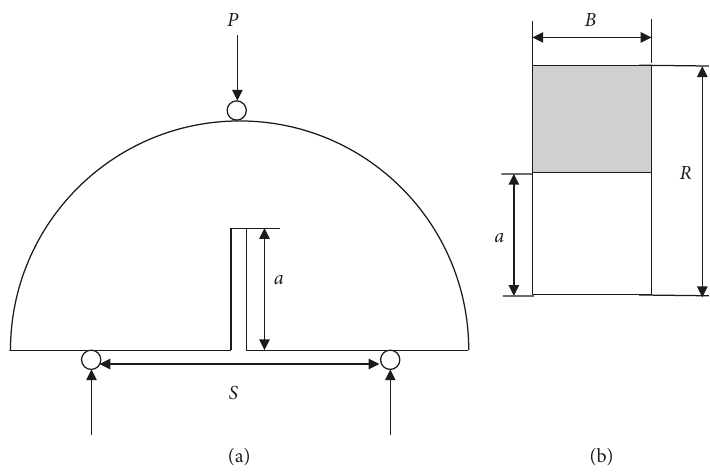
Figure 1: Loading diagram of the NSCB test specimen. (a) Diagram of test loading. (b) Sample profile.